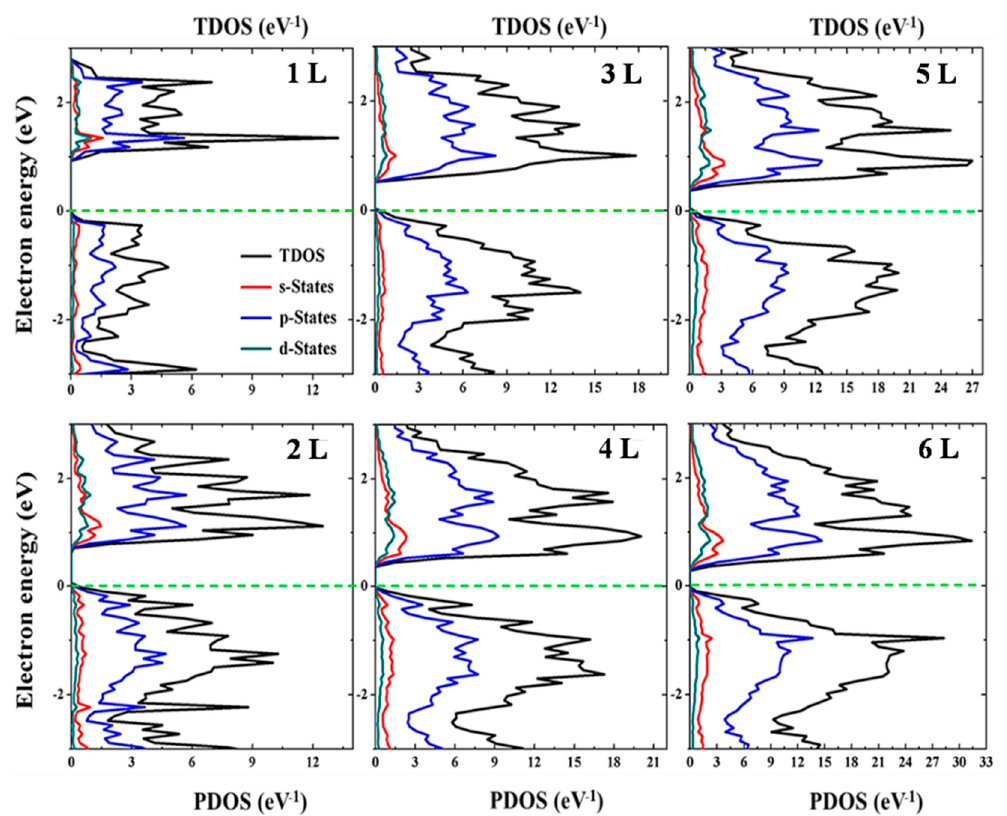
Figure 3. Total Density of States (TDOS) and Partial density of state (PDOS) of monolayer (1 L) and few-layer (2 L–6 L) Tellurene obtained from the PBE functional with spin orbital couple (SOC).